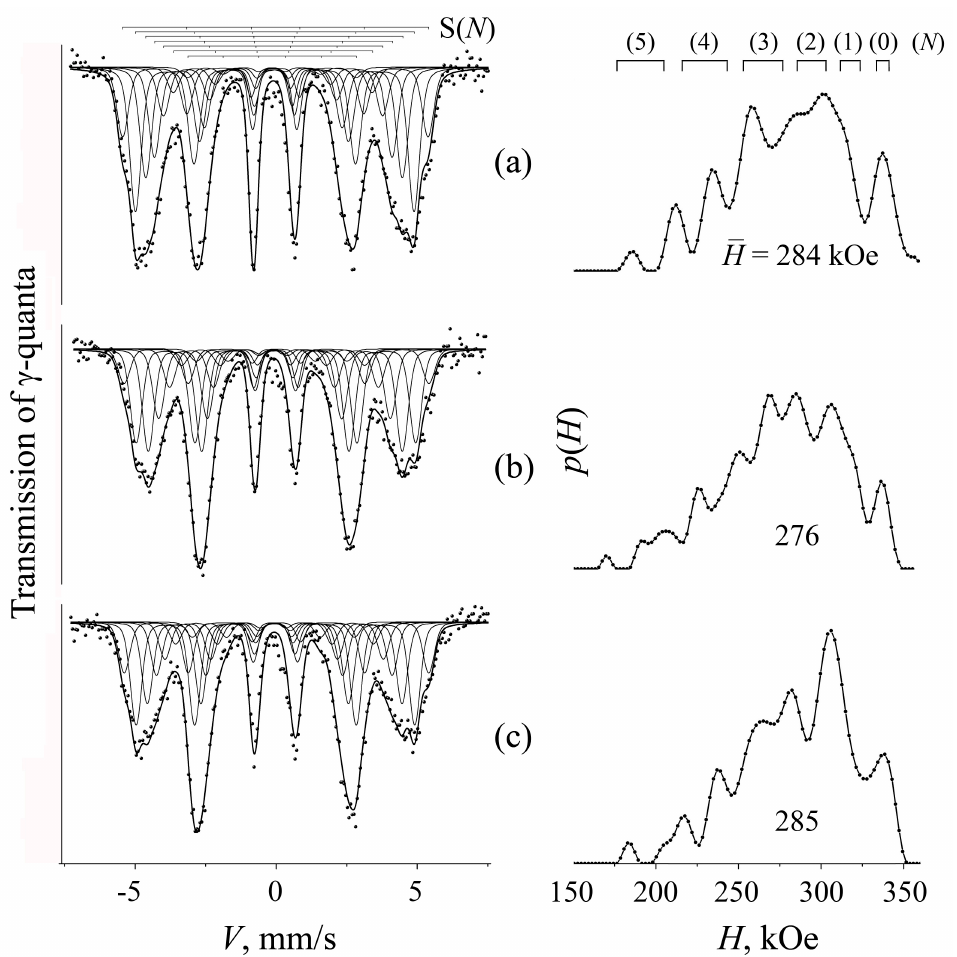
Figure 8. Spectra and the distribution p ( H ) for ferrite of the steel Fe 71.2 Cr 22.7 Mn 1.3 N 4.8 . Treatment (state): ( a ) annealed at 923 K for 2.5 h (aged); ( b ) aged and HPT treated at 80 K; ( c ) aged and HPT treated at 573 K. S ( N )—the subspectra-sextets with N atoms of Cr in the surrounding of Fe.